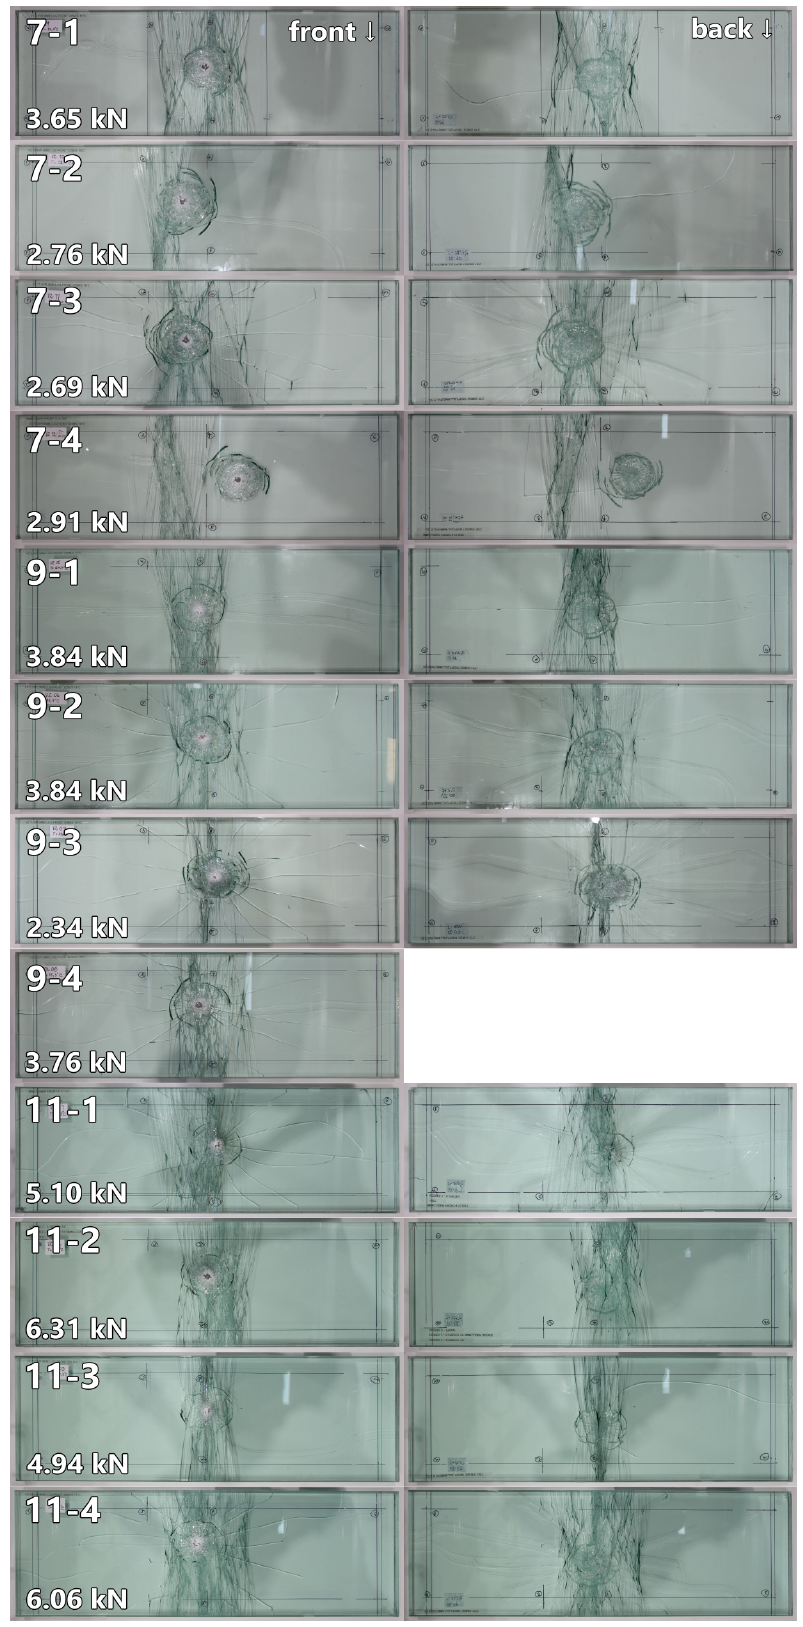
Figure A3. Specimens from the impact experiments after the subsequent quasi-static testing. Picture of the back of Specimen 9-4 is not available. Force values are peak quasi-static